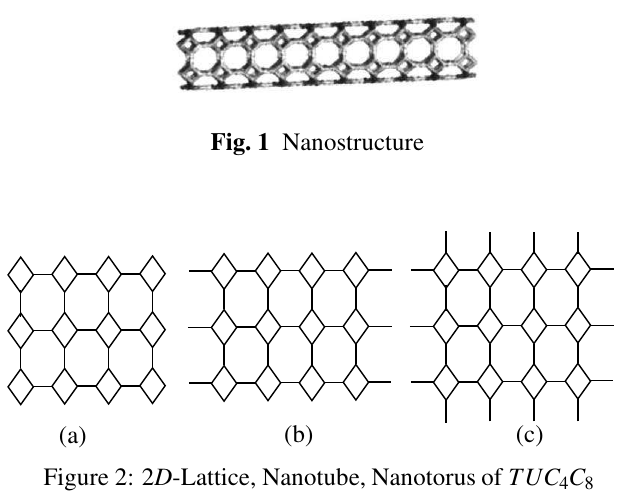
Figure 2: 2 D -Lattice, Nanotube, Nanotorus of TUC 4 C 8